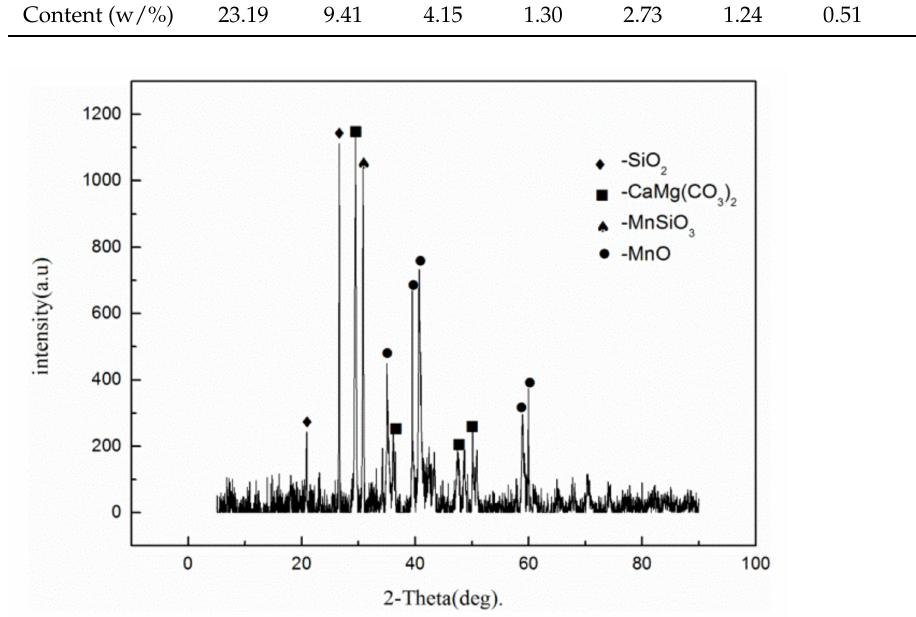
Figure 1. The XRD map of calcined manganese ore roasting